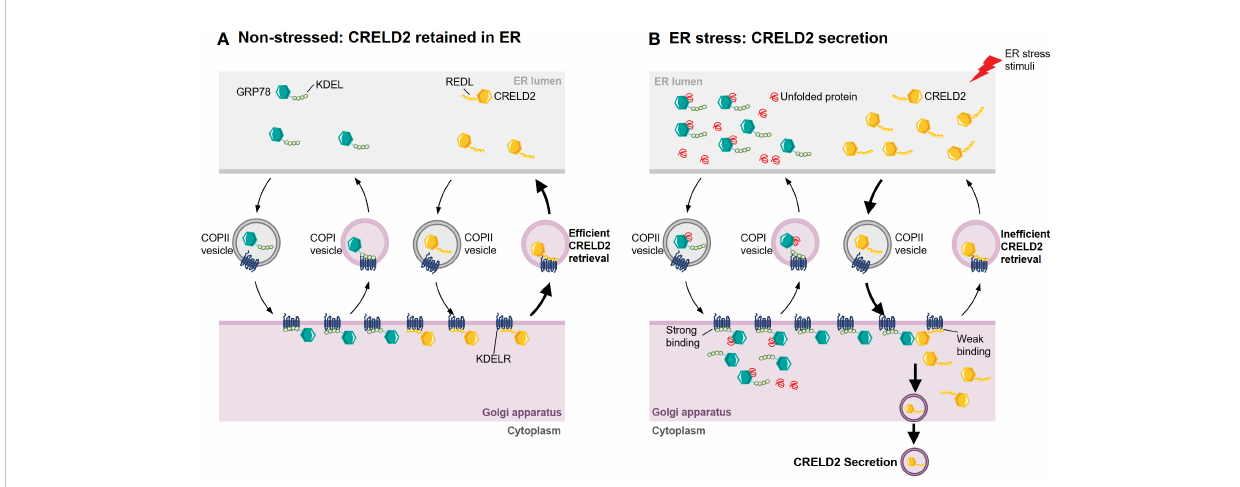
FIGURE 3 Hypothetical mechanism for the ER stress-induced CRELD2 secretion. Although ER-resident chaperones including GRP78 appear to be located solely in the ER lumen, they are widely distributed throughout the cell owing to a dynamic equilibrium achieved through retention and bidirectional transport between organelles. (A) Under normal conditions, GRP78 and CRELD2 can be traf fi cked to Golgi apparatus from ER via coat protein complexes II (COPII) vesicles. In the Golgi apparatus, the KDEL sequence of GRP78 and REDL sequence of CRELD2 can be recognized by the KDEL receptor (KDELR), which is located in the cis -Golgi. The binding of GRP78 or CRELD2 to KDELR triggers the incorporation of receptor-protein complex into vesicles such as COPI, thereby ef fi ciently transporting them back to the ER. (B) Upon ER stress, the levels of several ER-inducible proteins, including GRP78 and CRELD2, are upregulated; however, the relative expression of KDELR is not increased. Thus, GRP78 containing perfect ER retention motifs with a high af fi nity for KDELR will compete for KDELR with CRELD2 containing a low af fi nity motif. Therefore, CRELD2 that escapes to the Golgi apparatus cannot be ef fi ciently retrieved back to the ER, allowing CRELD2 to be